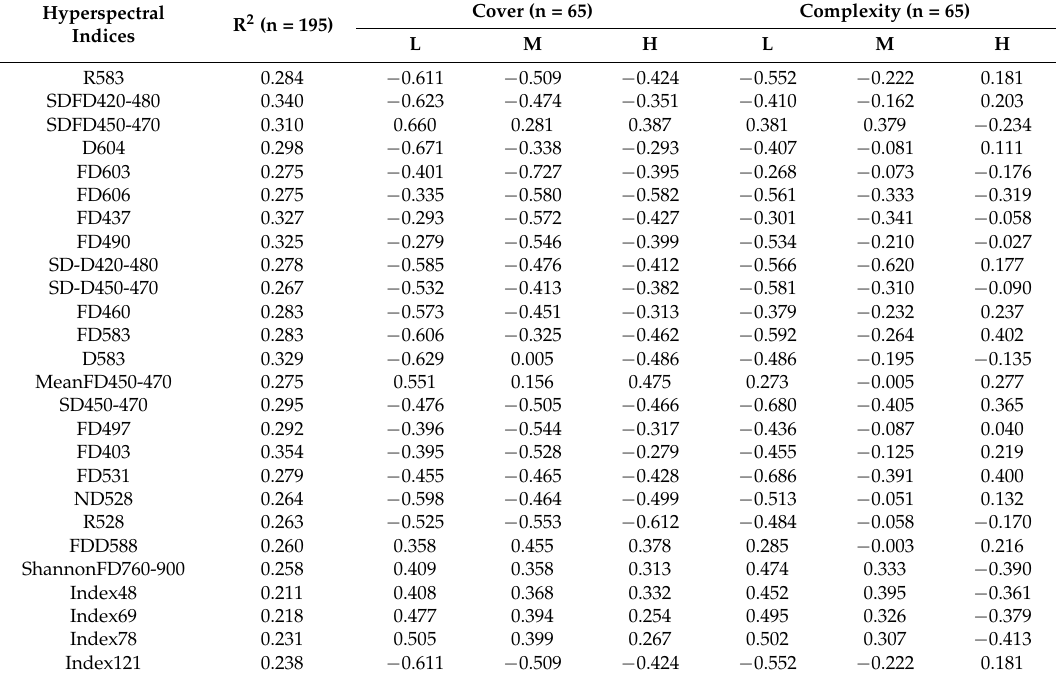
Table 2. Correlation coefficients between the hyperspectral indices and field-measured species richness displayed with their variation across community covers and complexities. Bold letters indicate significance at the 0.05